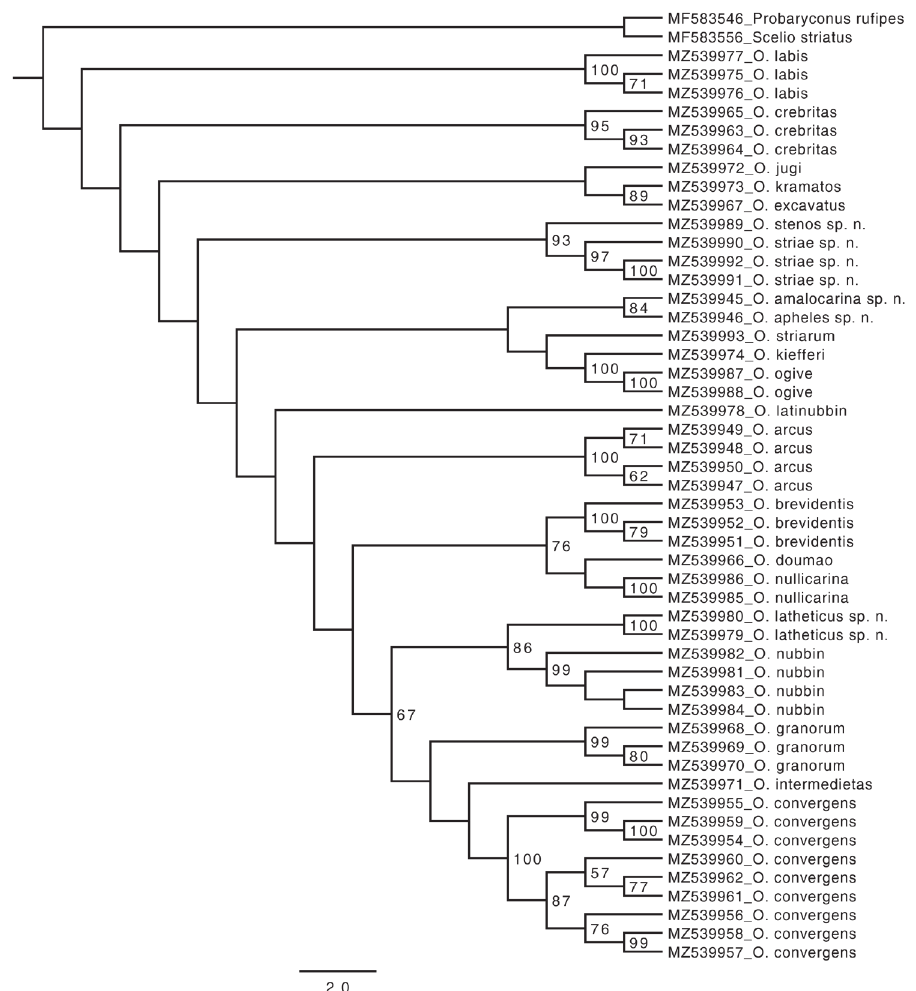
Figure 1. Maximum likelihood tree demonstrating the clustering of Oxyscelio COI barcodes. Bootstraps values of 50 and above are